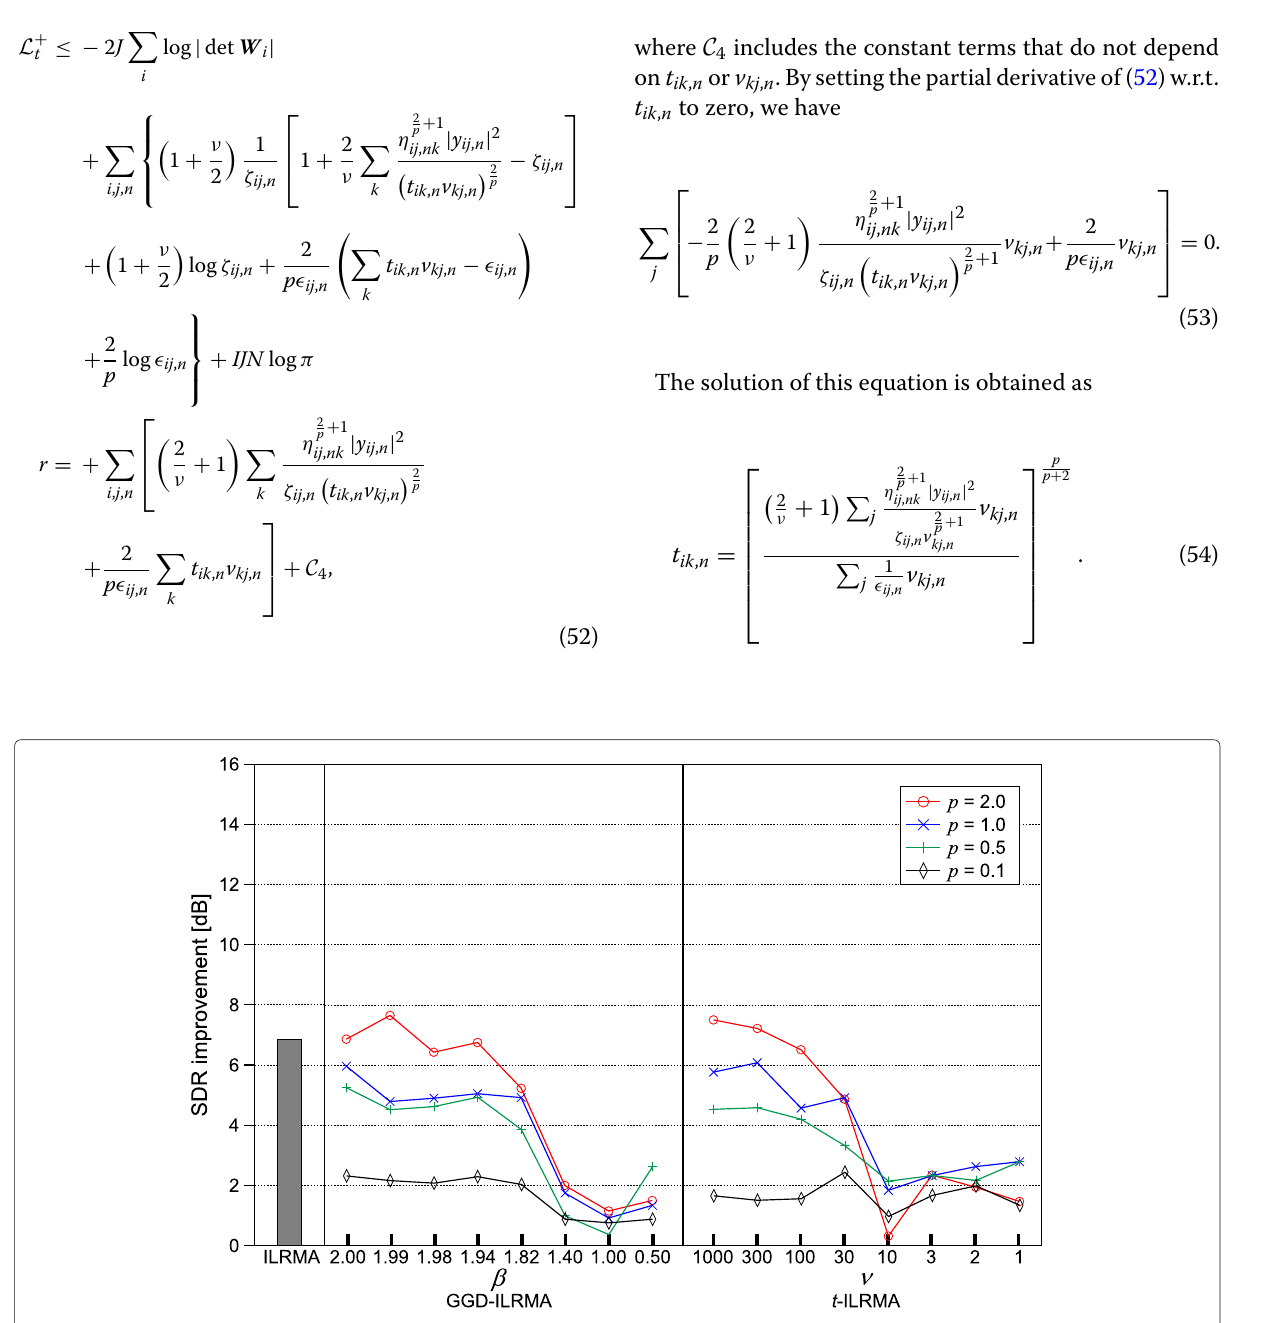
Fig. 24 Average SDR improvements of shorter Music 1 signal (2.5 s) with E2A_1 using fixed